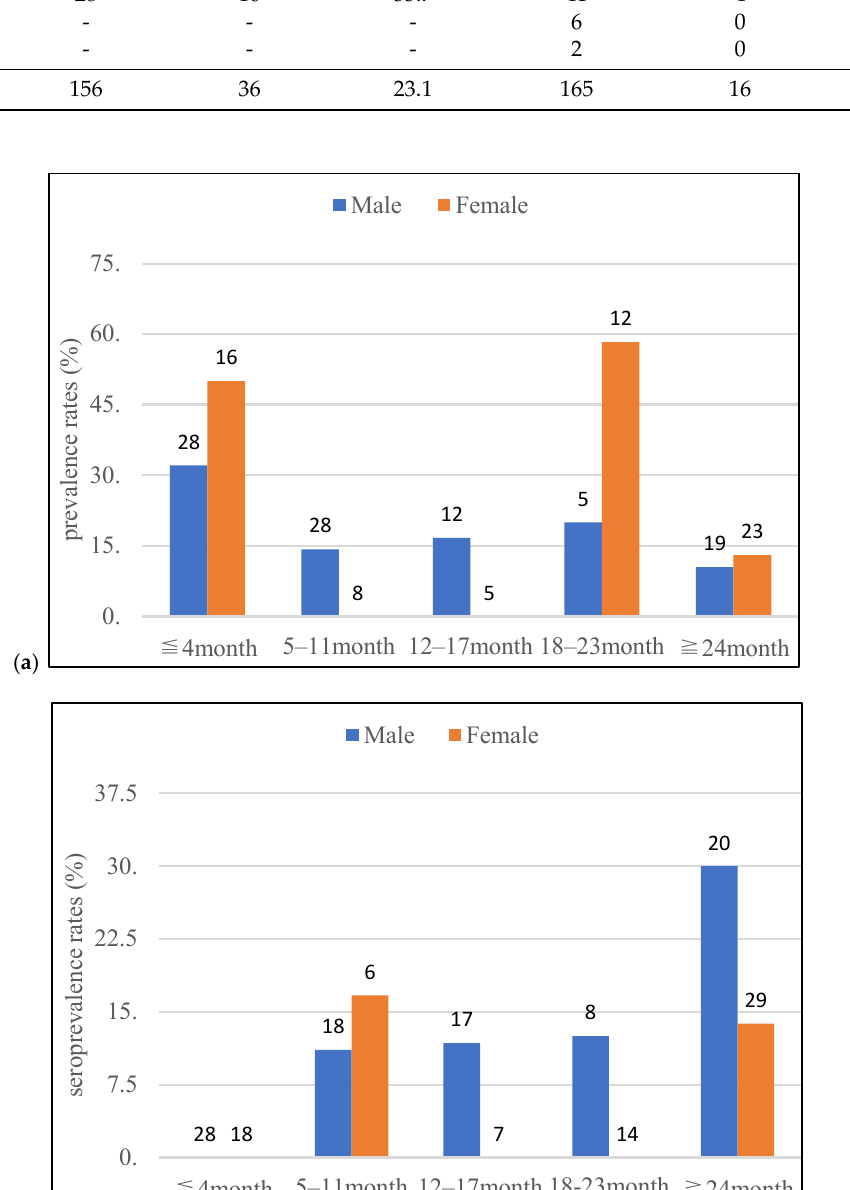
Figure 2. The leptospiral prevalence ( a ) and seroprevalence ( b ) rates, classified based on sex and age, in raccoons investigated in this study from June 2020 to April 2022 in Tama area, Tokyo, Japan (Number on the graph indicates the number of tested raccoons).